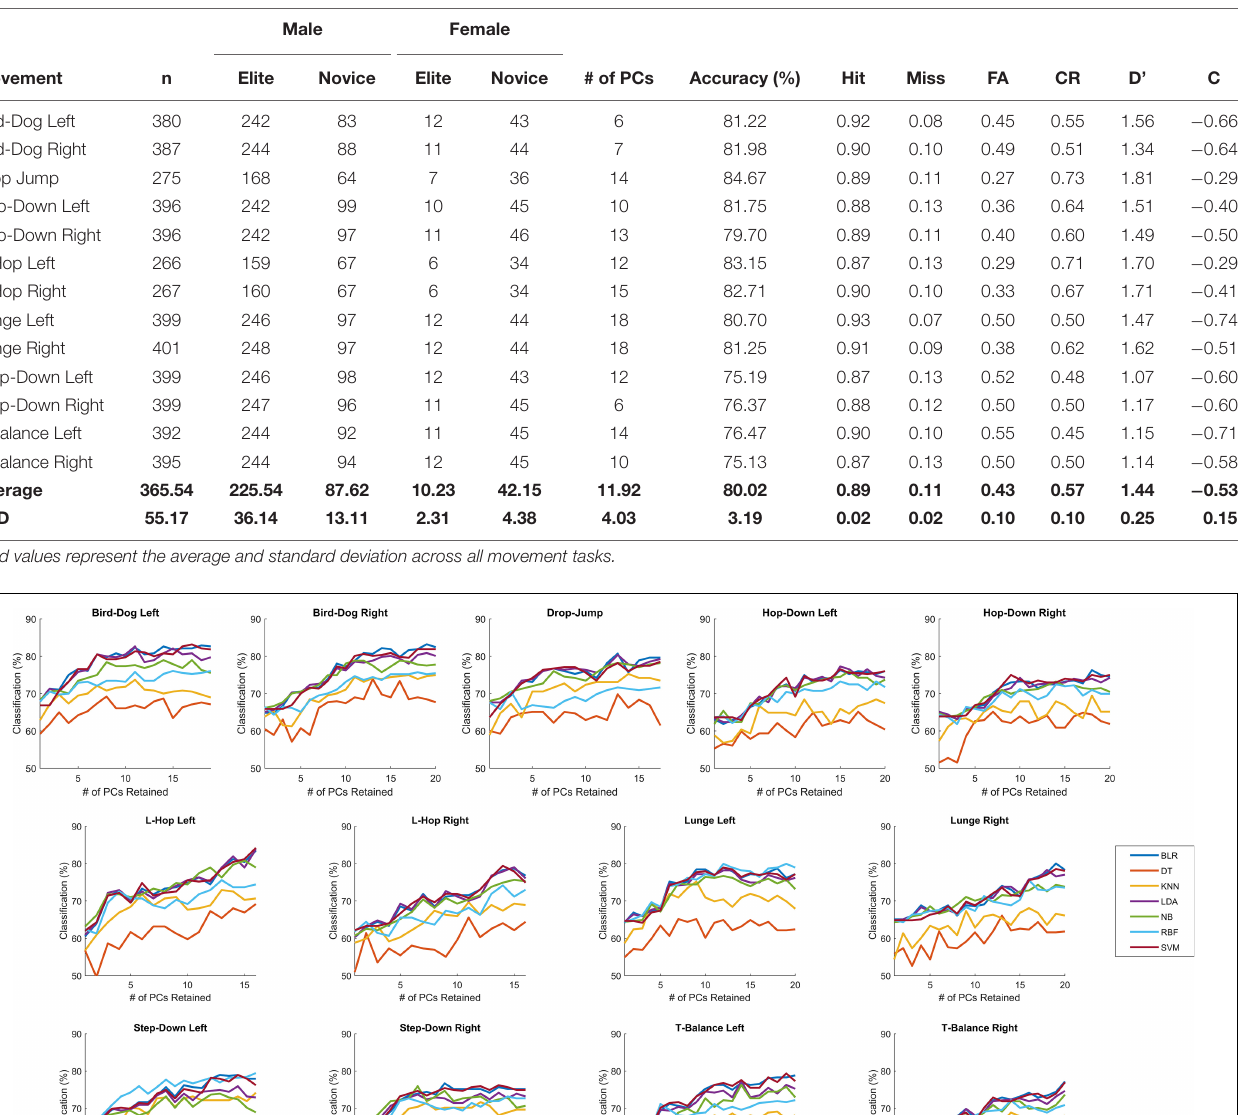
lunge left, NB performed as well as the linear classifiers, however, for all other tasks, they performed in between the linear classifiers and DT, kNN, and RBF. Since there were minimal differences ( < 0.5%) on the average classification rates for all tasks between BLR, LDA, and SVM, and to be able to compare the current results to previous results (Ross et al., 2018), LDA was selected for further analysis. When using LDA, the optimal number of PCs